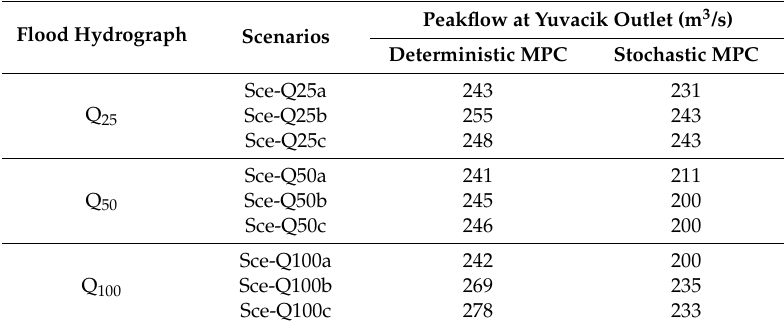
Table 3. Peakflow assessment of deterministic and stochastic closed-loop MPC results for different inflow conditions with forecast horizons of 48 h.